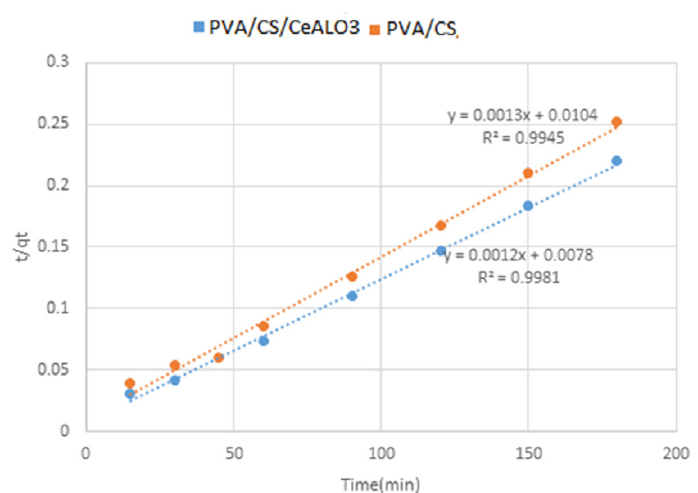
Fig. 11. Pseudo-second-order plot sorption of MB onto PVA/CS and PVA/CS/ CeAlO